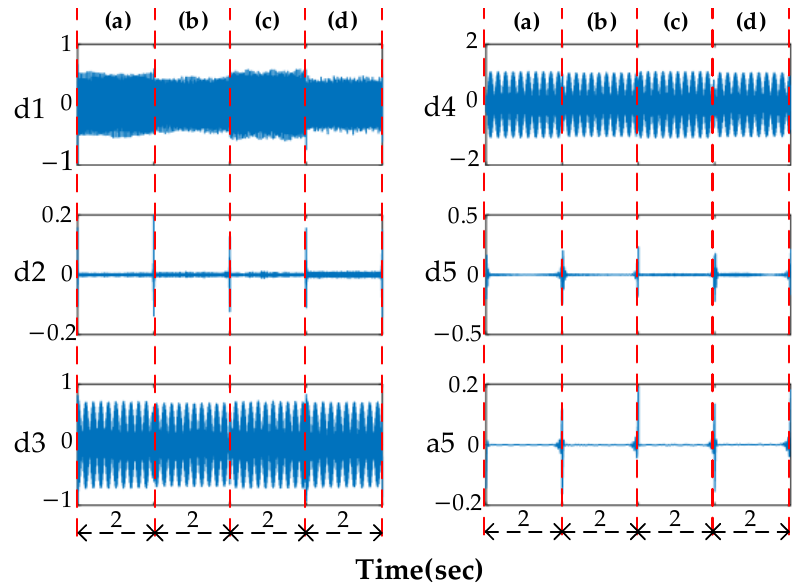
Figure 4. The MRA of current signal. ( a ) Normal motor, ( b ) bearing fault, ( c ) interturn short circuit, ( d ) broken rotor bar.